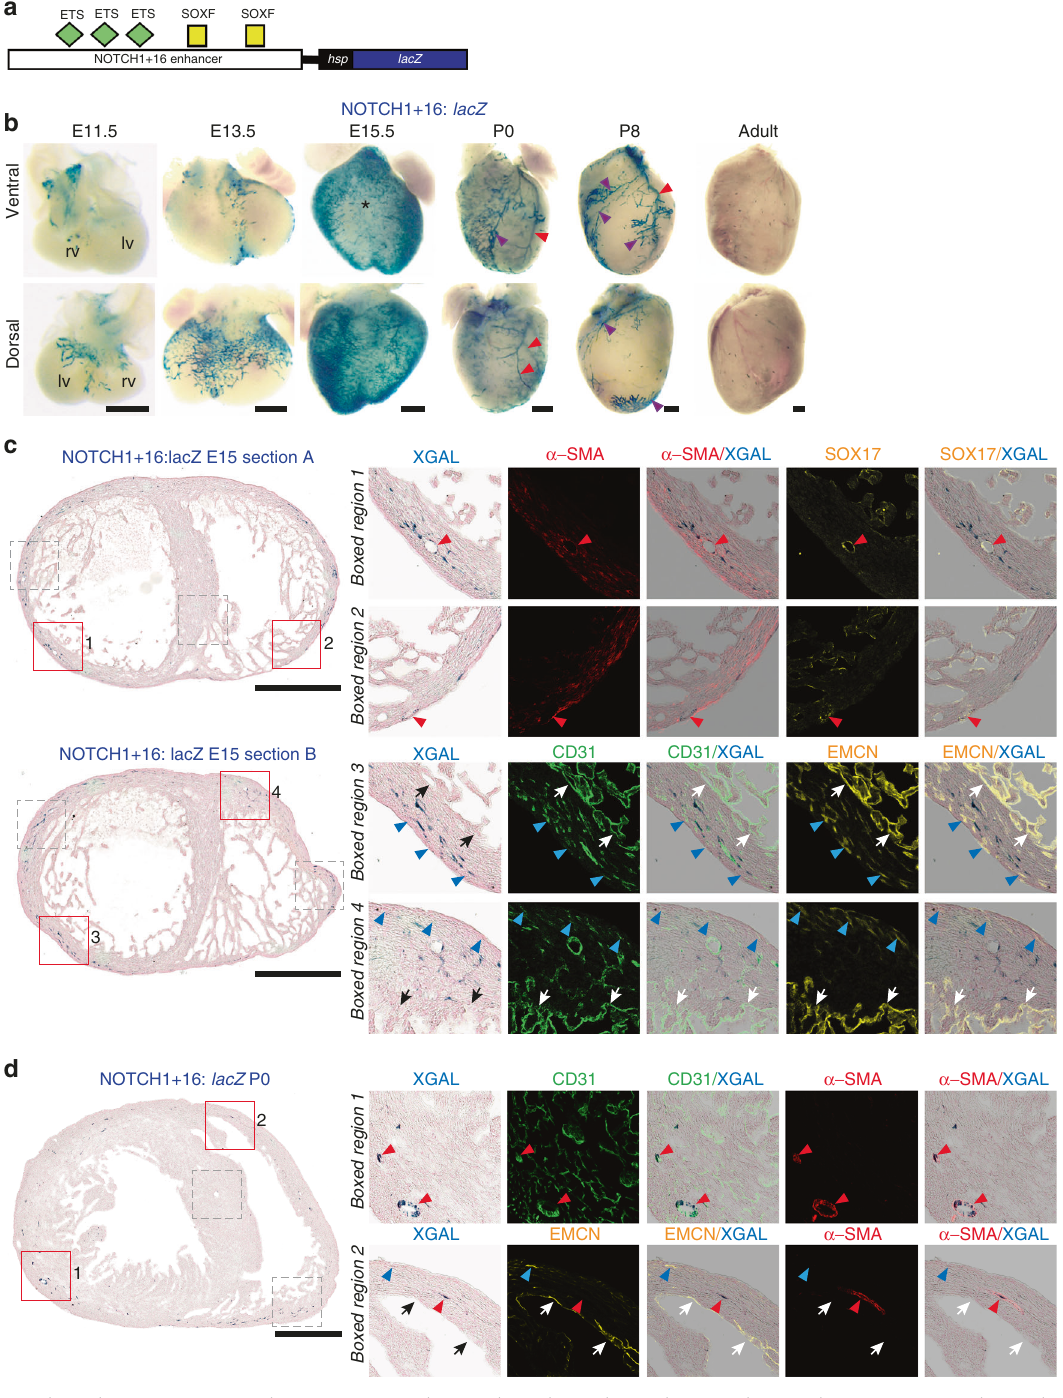
Fig. 5 The SOXF-dependent NOTCH1 + 16 enhancer is restricted to SV-derived vessels. a Schematic showing the NOTCH1 + 16 enhancer: lacZ transgene, with veri fi ed binding motifs for ETS and SOXF transcription factor represented by coloured shapes 21 . b Whole-mount images of NOTCH1 + 16: lacZ transgenic hearts. NOTCH1 + 16 enhancer activity (blue staining) is not seen on the ventral aspect of the developing heart (*), is seen in the vascular plexus on the dorsal aspect in the embryonic heart, and is restricted to coronary arteries and lymphatic vessels (red and purple arrowheads) at P0 and P8. All images are from a single transgenic line and are representative of at least fi ve biologically independent samples, little variation in staining pattern was seen. c, d Transverse sections through NOTCH1 + 16: lacZ E15.5 ( c ) and P0 ( d ) hearts show NOTCH1 + 16 enhancer activity (blue) compared to pan-endothelial marker CD31 (green), the arterial markers α -SMA (red) and SOX17 (green) and the venous/endocardial marker EMCN (yellow). Representative of fi ve ( c ) and four ( d ) biologically independent immunohistological experiments, with similar staining patterns seen in all. Grey boxed regions are shown in Supplementary Fig. 13b, c. Black/white arrows indicate the endocardium, red arrowheads indicate arteries, blue arrowheads indicate veins, purple arrowheads indicate lymphatics. rv, right ventricle; lv, left ventricle. Black scale bars represent 500 μ